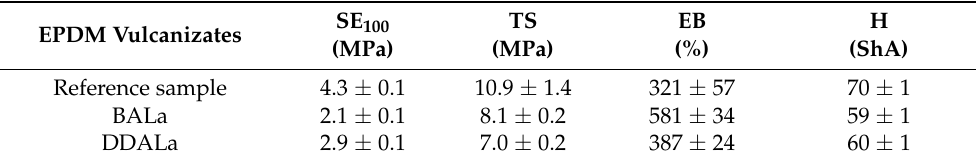
Table 9. Mechanical properties and hardness of EPDM vulcanizates with TSILs (SE 100 , modulus at a relative elongation of 100%; TS, tensile strength; EB, elongation at break; H, hardness). SE 100 EPDM Vulcanizates